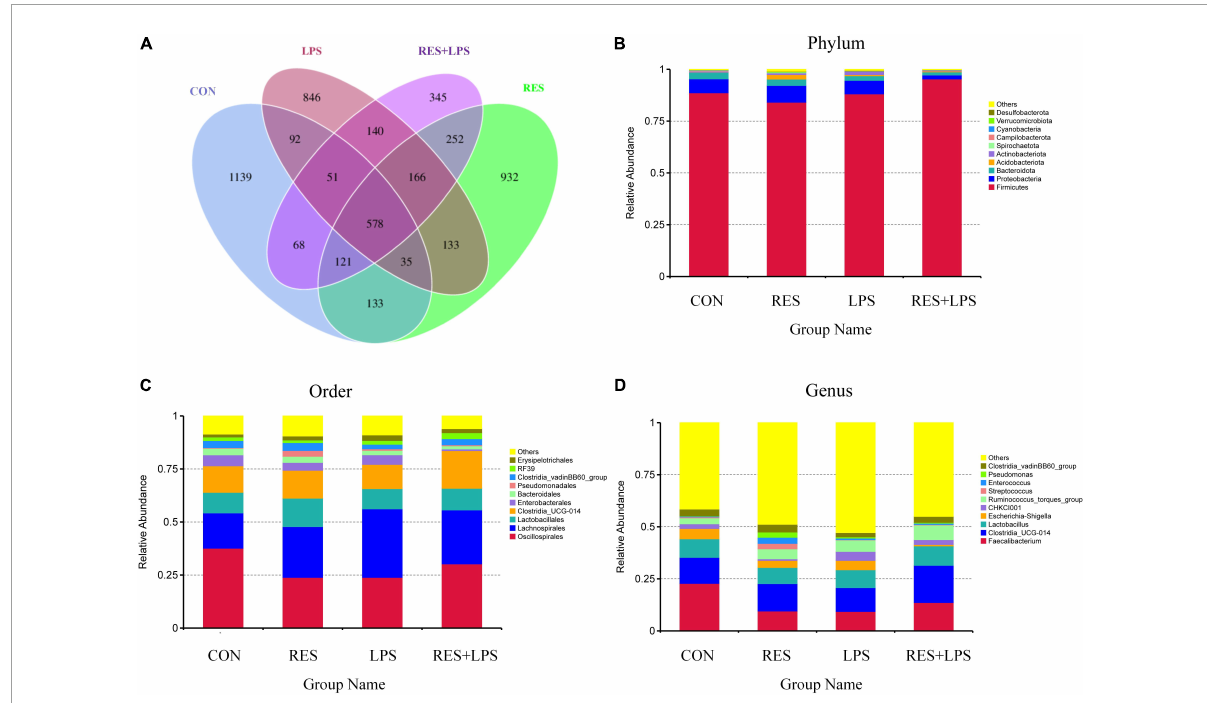
FIGURE3 The Venn diagram and relative abundances of bacteria at the phylum, order, and genus levels. (A) Venn diagram. (B) Top 10 bacteria at phylum level. (C) Top 10 bacteria at order level. (D) Top 10 bacteria at genus order. CON, control; RES, resveratrol; LPS, lipopolysaccharide; RES + LPS, dietary resveratrol treatment followed by LPS challenge.